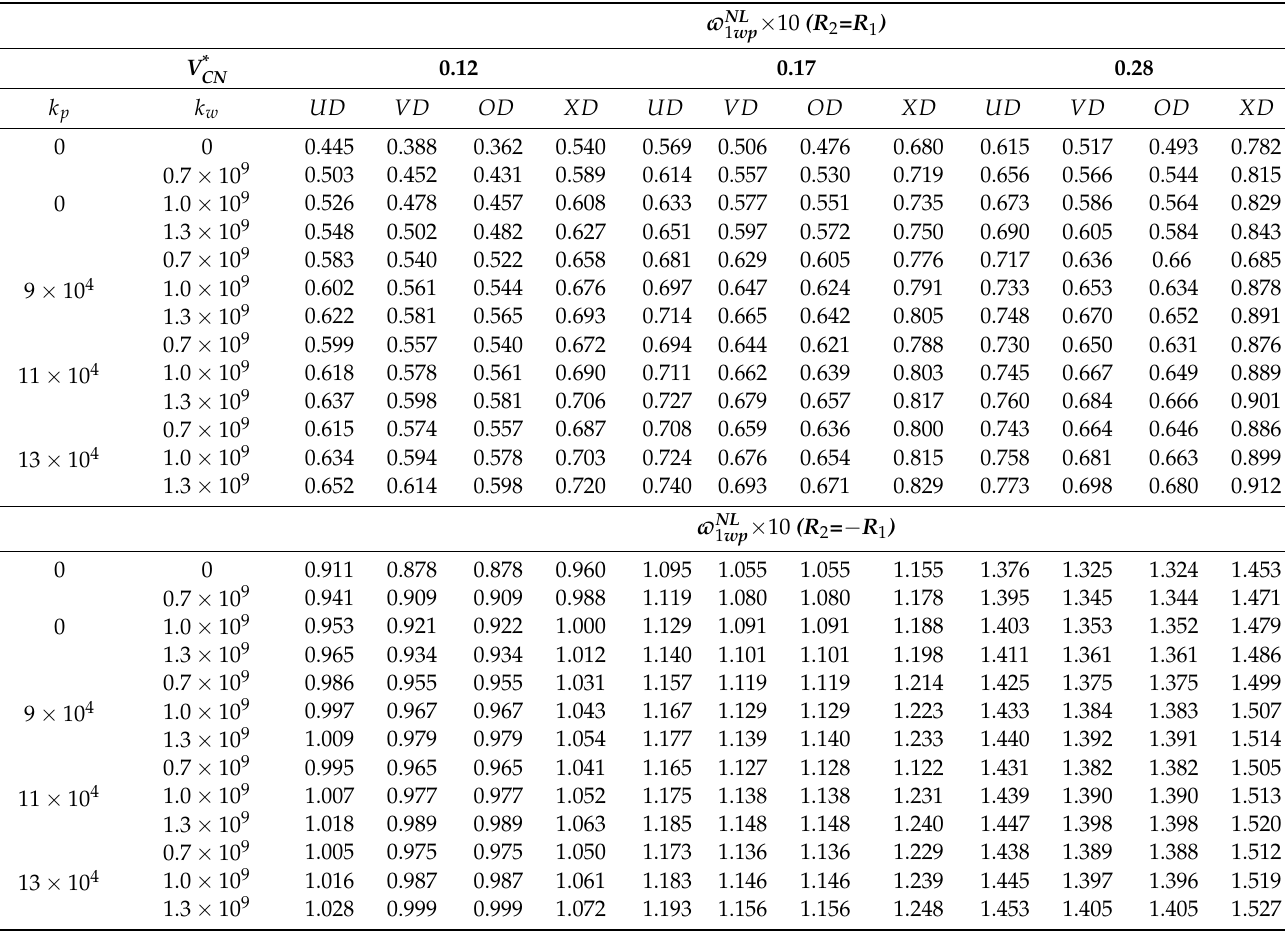
Table 4. Variation in NLFVF for shallow spherical and hypar shells with CNTs resting on a W-EF and PF with various foundation elastic parameters, versus V ∗ CN